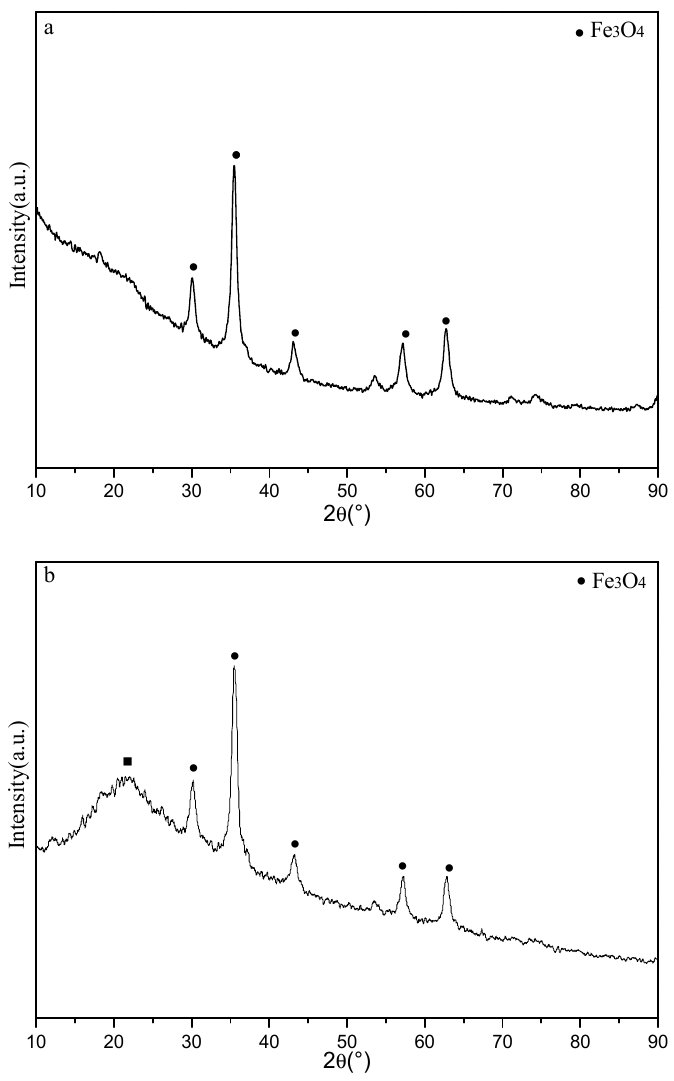
Figure 2. X-ray diffraction (XRD) patterns of 10%-Fe 3 O 4 @ SC adsorbent. ( a ) fresh, ( b ) after adsorption.